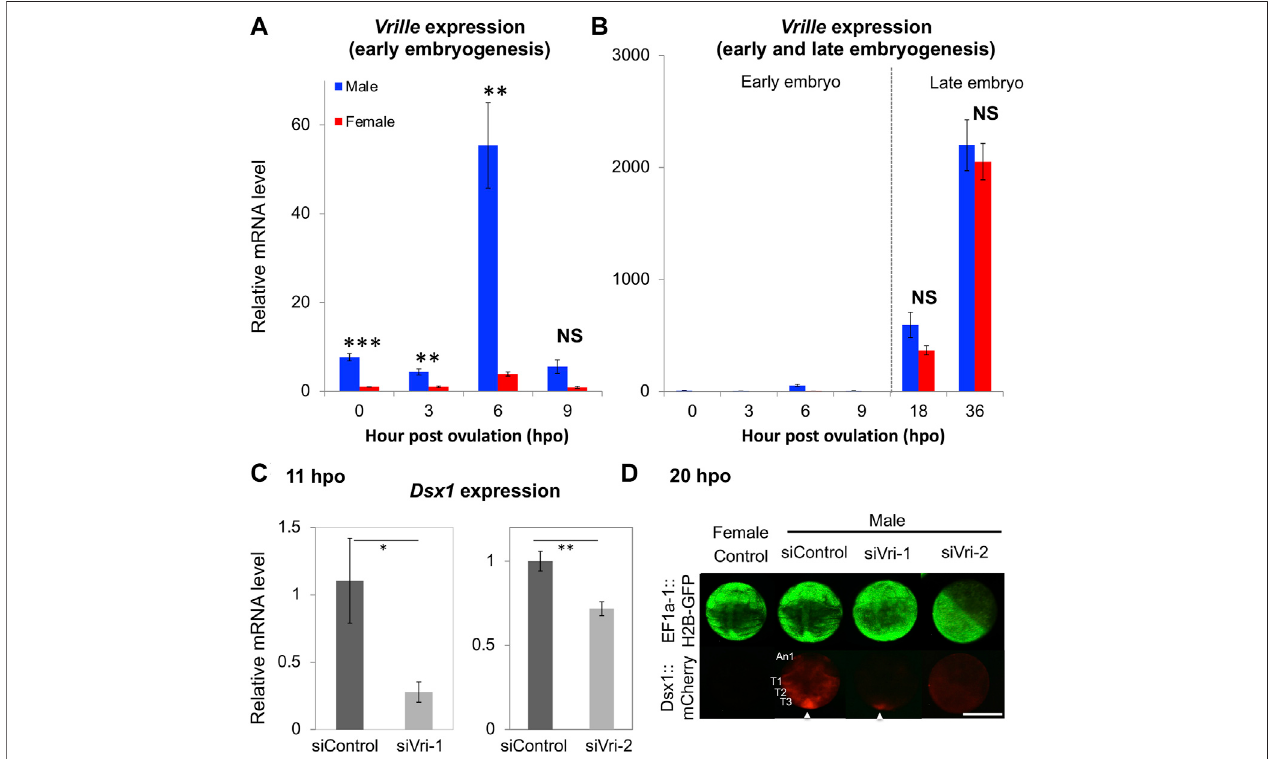
FIGURE 10 | Vrille ( Vri ) expression in wild-type and knockdown embryos of D. magna . (A) Sexual dimorphism of Vri expression at early embryonic stages (0, 3, 6, and 9-hpo) ofwild-type. (B) Non-sex-speci fi c Vri expression inthelate embryos(18 and 36-hpo)ofwild-type. The Vri expression levels werenormalized tothe reference gene expression levels (ribosomal protein L32 ). The normalized Vri expression in female embryos at 0-hpo was set to one. (C) The Dsx1 expression level at 11 h after siRNA injection was measured by qRT-PCR. siControl, siVri-1 and siVri-2 indicate control-, Vri_siRNA_1, and Vri_siRNA_2 injected males, respectively. Each experiment was performed in biological triplicate. For each replicate, nine or ten embryos were pooled in one tube, subjected to total RNA extraction, and used for quantitation. (D) Spatial expression pattern of mCherry as a reporter of Dsx1 gene expression in Vrille knockdown embryos at 20-hpo. An1, fi rst antennae; T1, thoracic appendage1;T2,thoracicappendage2;T3,thoracicappendage3;Anarrowheadindicatestheposteriorgrowthzone;Scalebars:200 μ m.(Student ’ s t -test;* p < 0.05; ** p < 0.01; *** p < 0.001; NS, No signi fi cant different). Adapted from Mohamad Ishak et al. (2017).